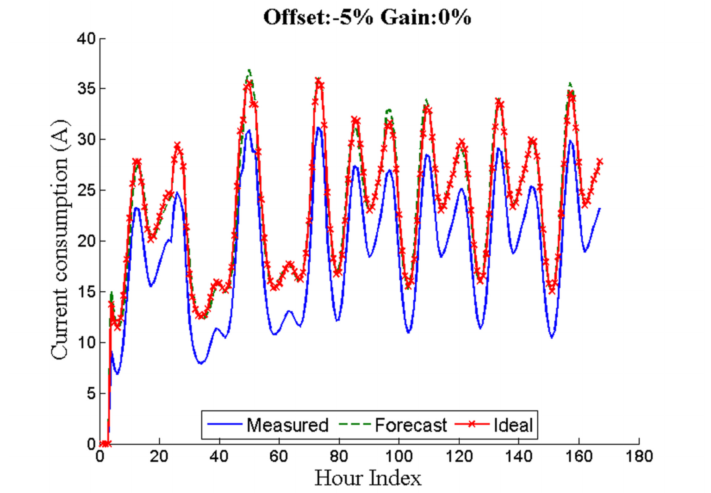
Figure 4. Seven days with an offset error of − 5%.